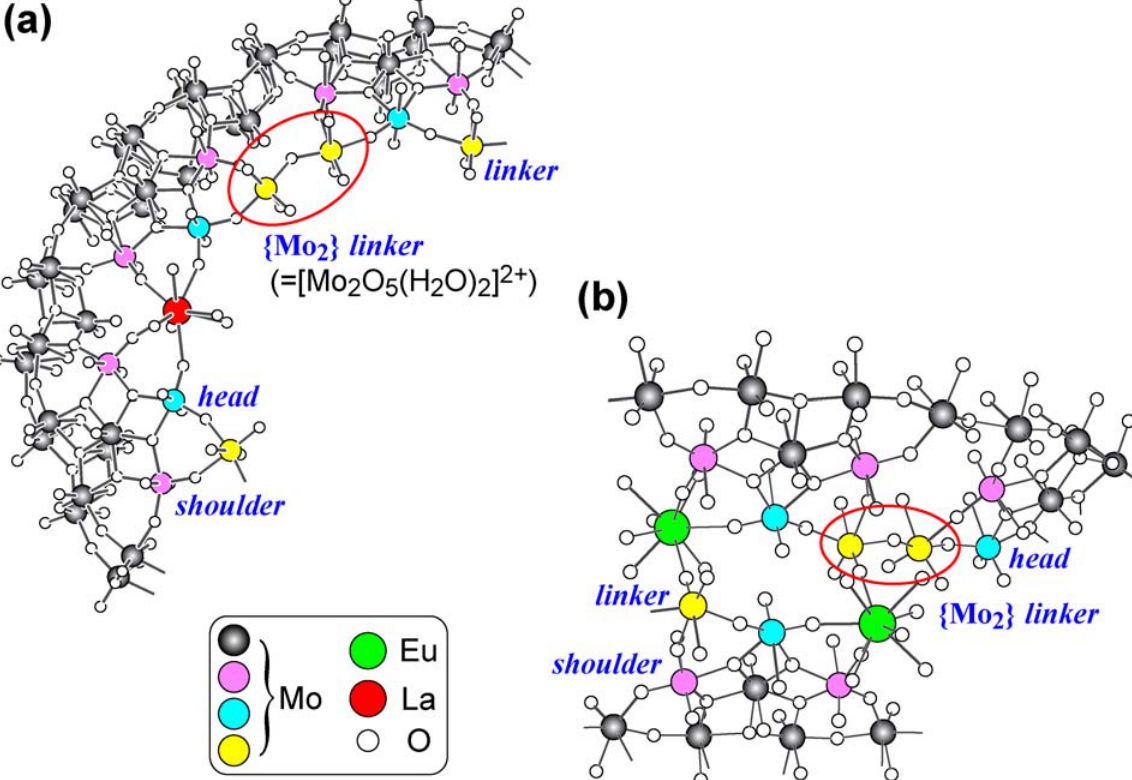
Eu } (b). Pink-, blue- and yellow colored Mo atoms are at 128 4 2